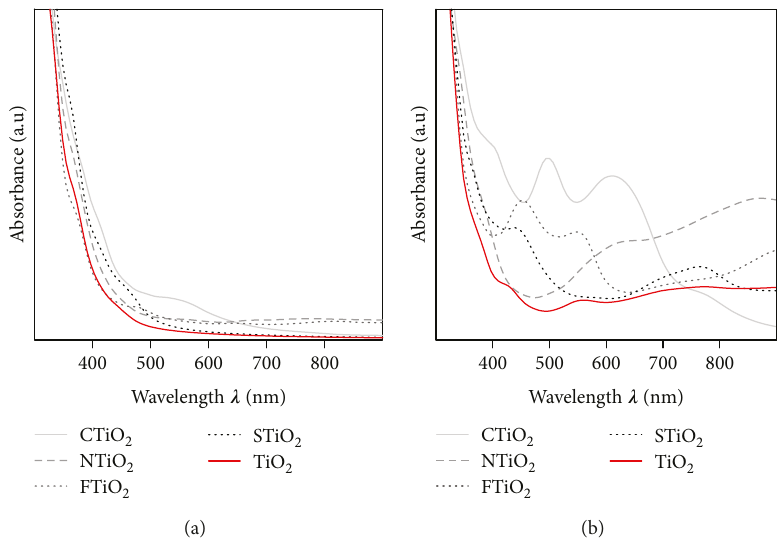
Figure 7: The UV-visible spectrum of anatase surface. (a) C-, N-, F-, and S-doped TiO Results obtained with the GGAU